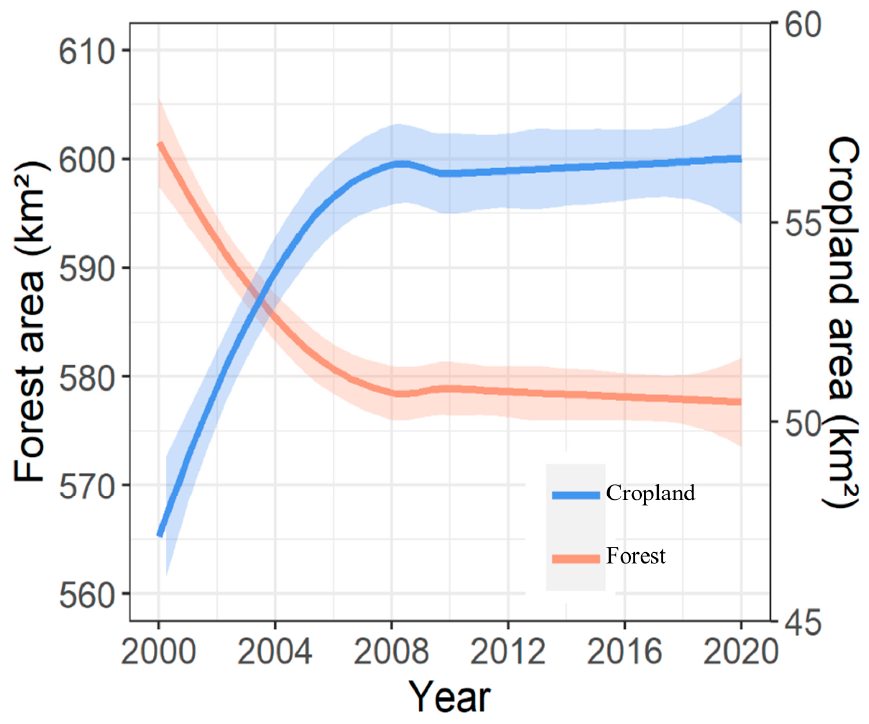
Figure 9. The temporal variation of forest and cropland in the period of 2000–2020 in the Amazon basin.